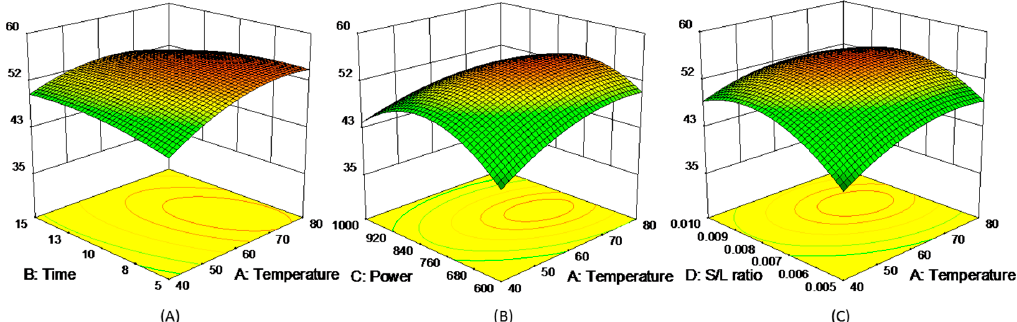
Figure 5. 3D response surface plots of SAB.